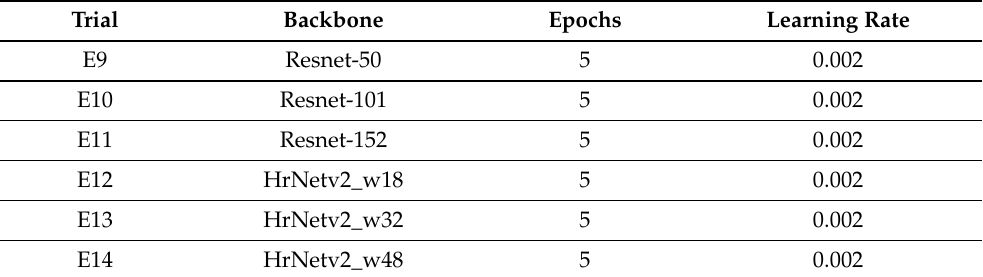
Table 13. Trials performed for different algorithms selected for human caruncle detection task.